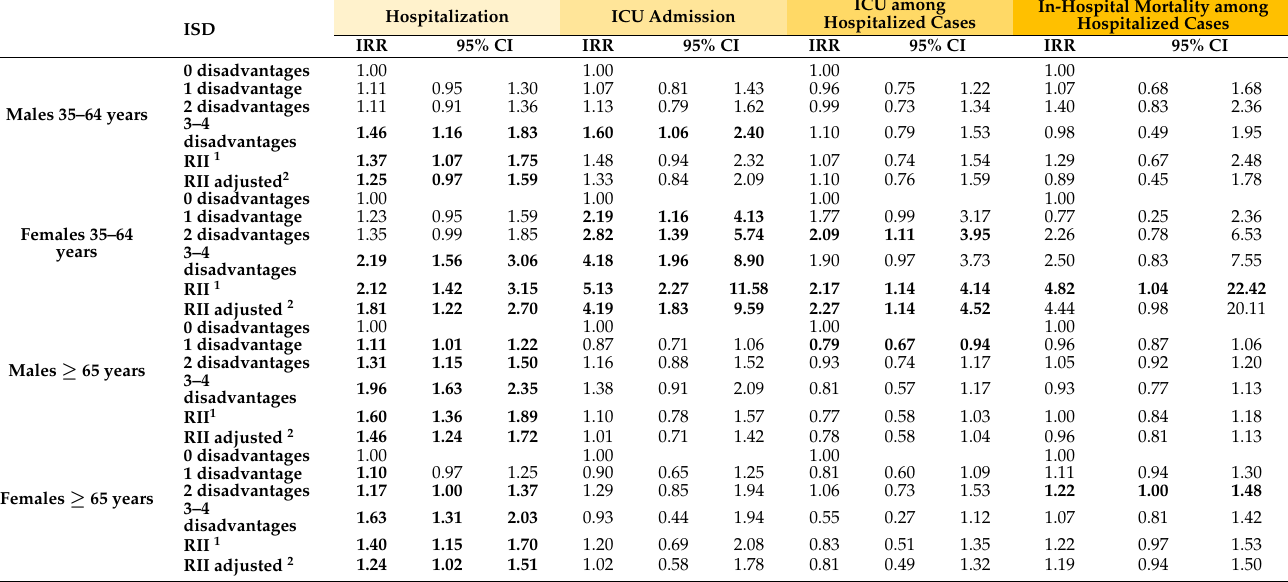
Table 3. Incidence of hospitalization and ICU admission rate ratios (IRR), Risk of ICU admission and in-hospital mortality Ratio (RR) among hospitalized people and Relative Index of Inequality (RII) for the index of social disadvantage (ISD) by gender and age